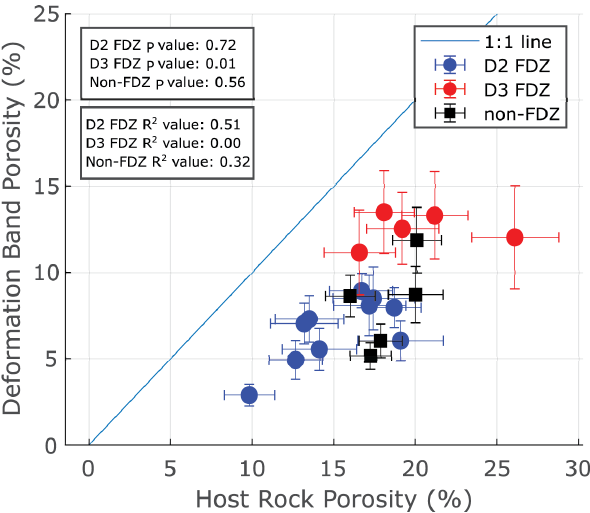
Figure 10. (a) Measured host-rock porosity (%) plotted against porosity measured in the deformation band (%). Each data point represents a thin section where porosity was measured in the host rock and deformation band. All deformation bands exhibit a reduc- tion in porosity compared with the host rock. The p value refers to the Pearson correlation coefficient value. The R 2 value ( R -squared) represents the variance from a best fit. Raw statistical data are shown in Sect.